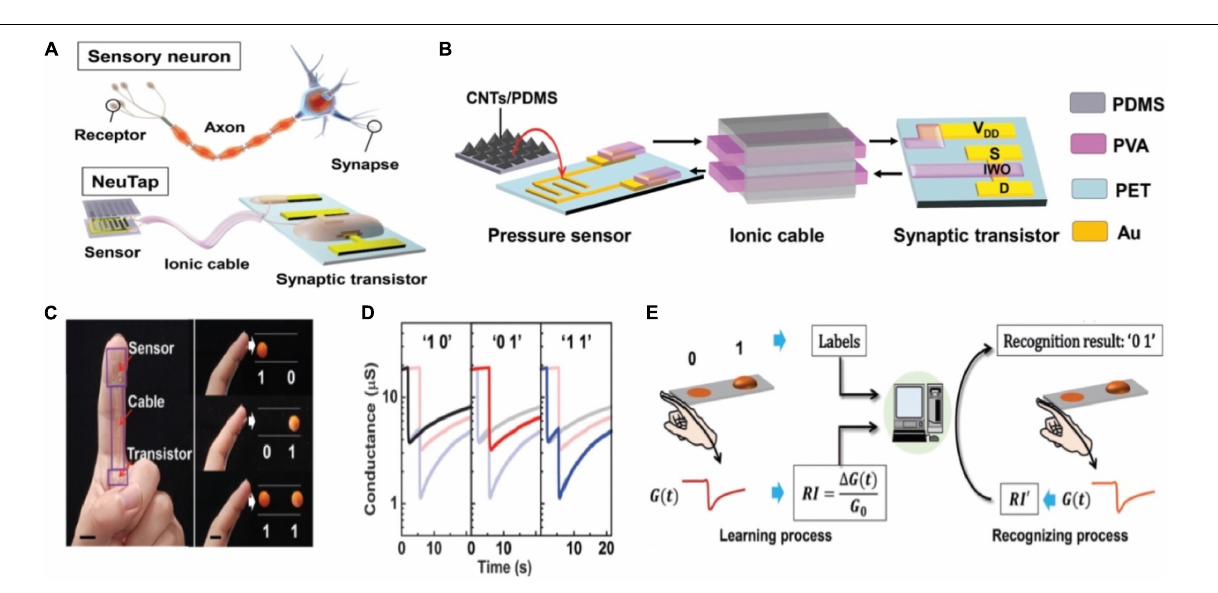
FIGURE 18 | (A) Sensory neuron compared to the NeuTap. (B) Schematic of the details of the NeuTap. (C) Digital image of the NeuTap on one finger and the pattern pairs as well as the corresponding two-bit binary code labels. (D) The responses of the NeuTap to three pattern pairs. (E) The machine learning method for the perceptual learning emulation (adapted from Wan et al.,